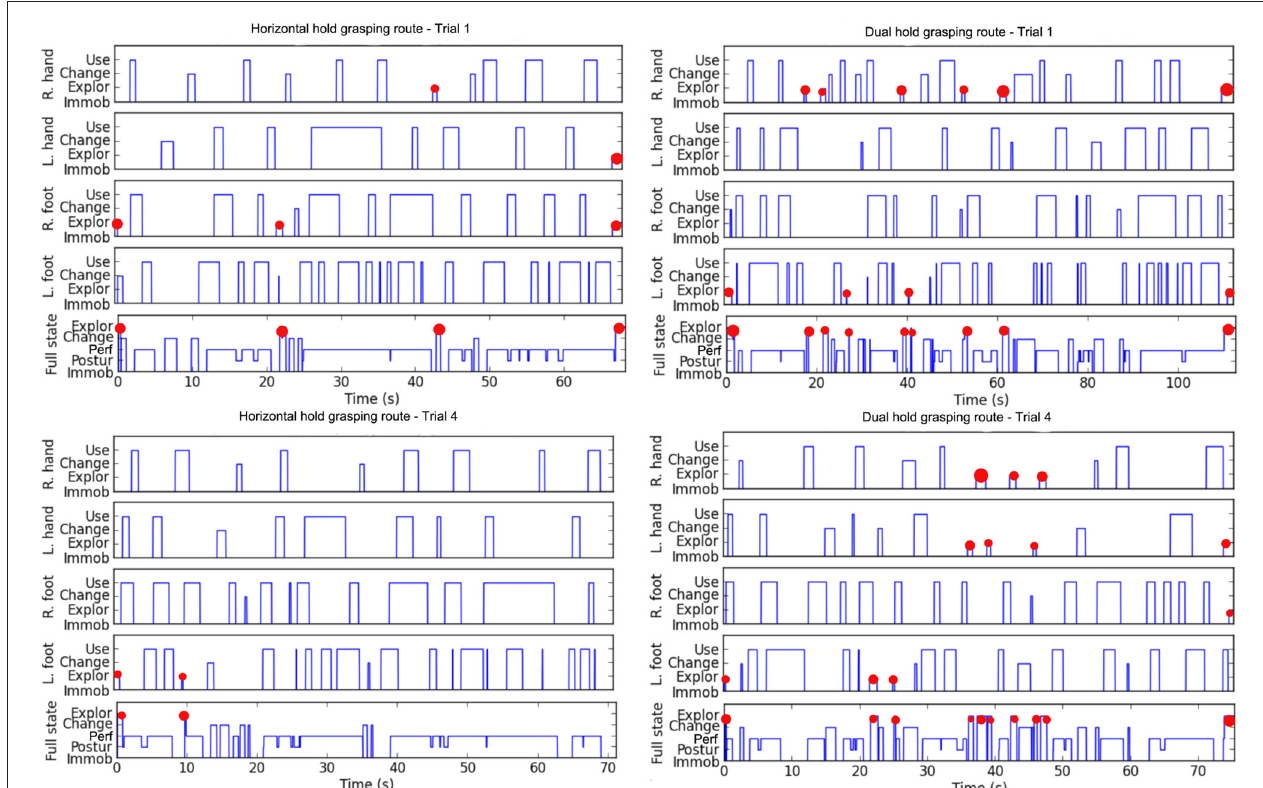
FIGURE 4 | Example for one participant of the climbing states time series for the right hand (R. hand), the left hand (L. hand), the right foot (R. foot), the left foot (L. foot) and the full body state based on the decision tree designed by Boulanger et al. (2016). The four panels exemplified (by red dots) the lower hold exploratory movements on the H route (Left) than on the Dual route (Right) , and the decrease of hold exploratory movements from trial 1 (Top) to trial 4 (Down) .